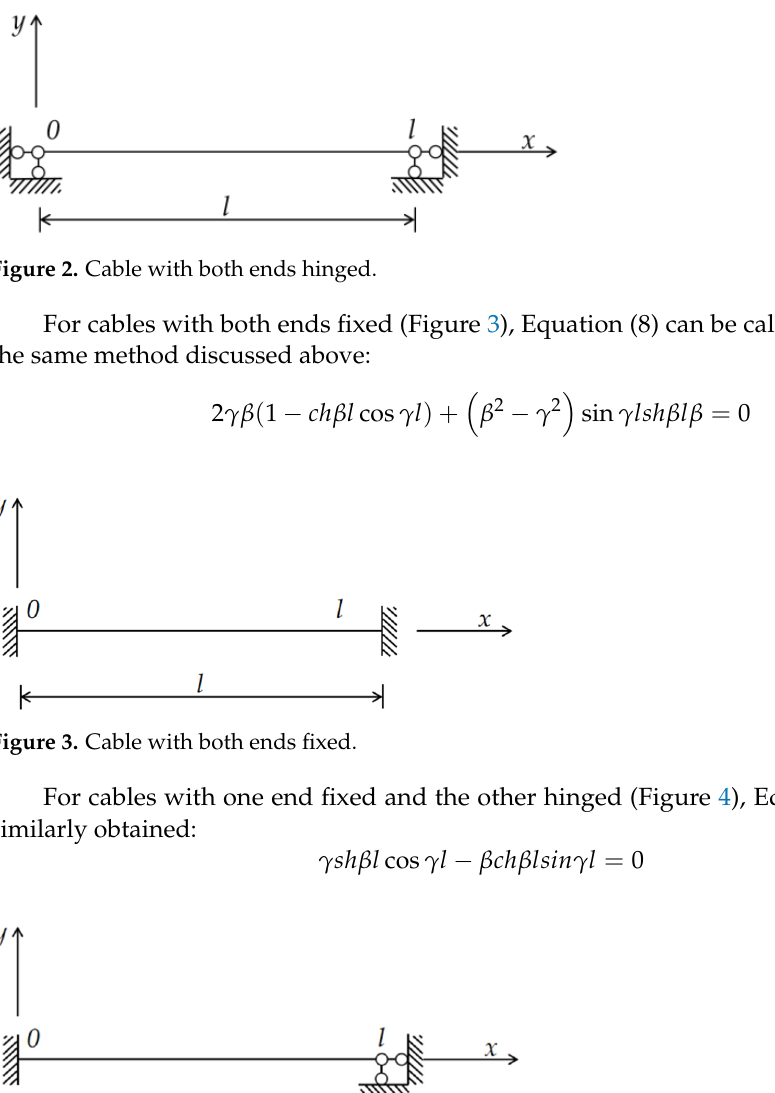
Figure 4. Cable with one end fixed and the other hinged. Figure 3. Cable with both ends fixed.